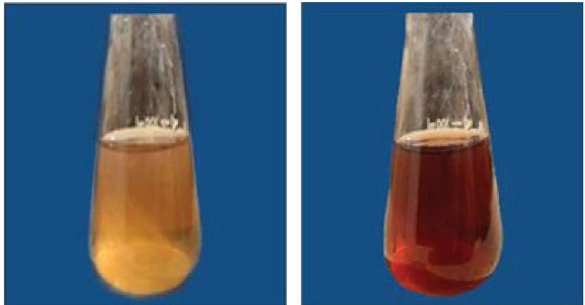
Figure 1: Te change in the color of the solution from yellow to dark